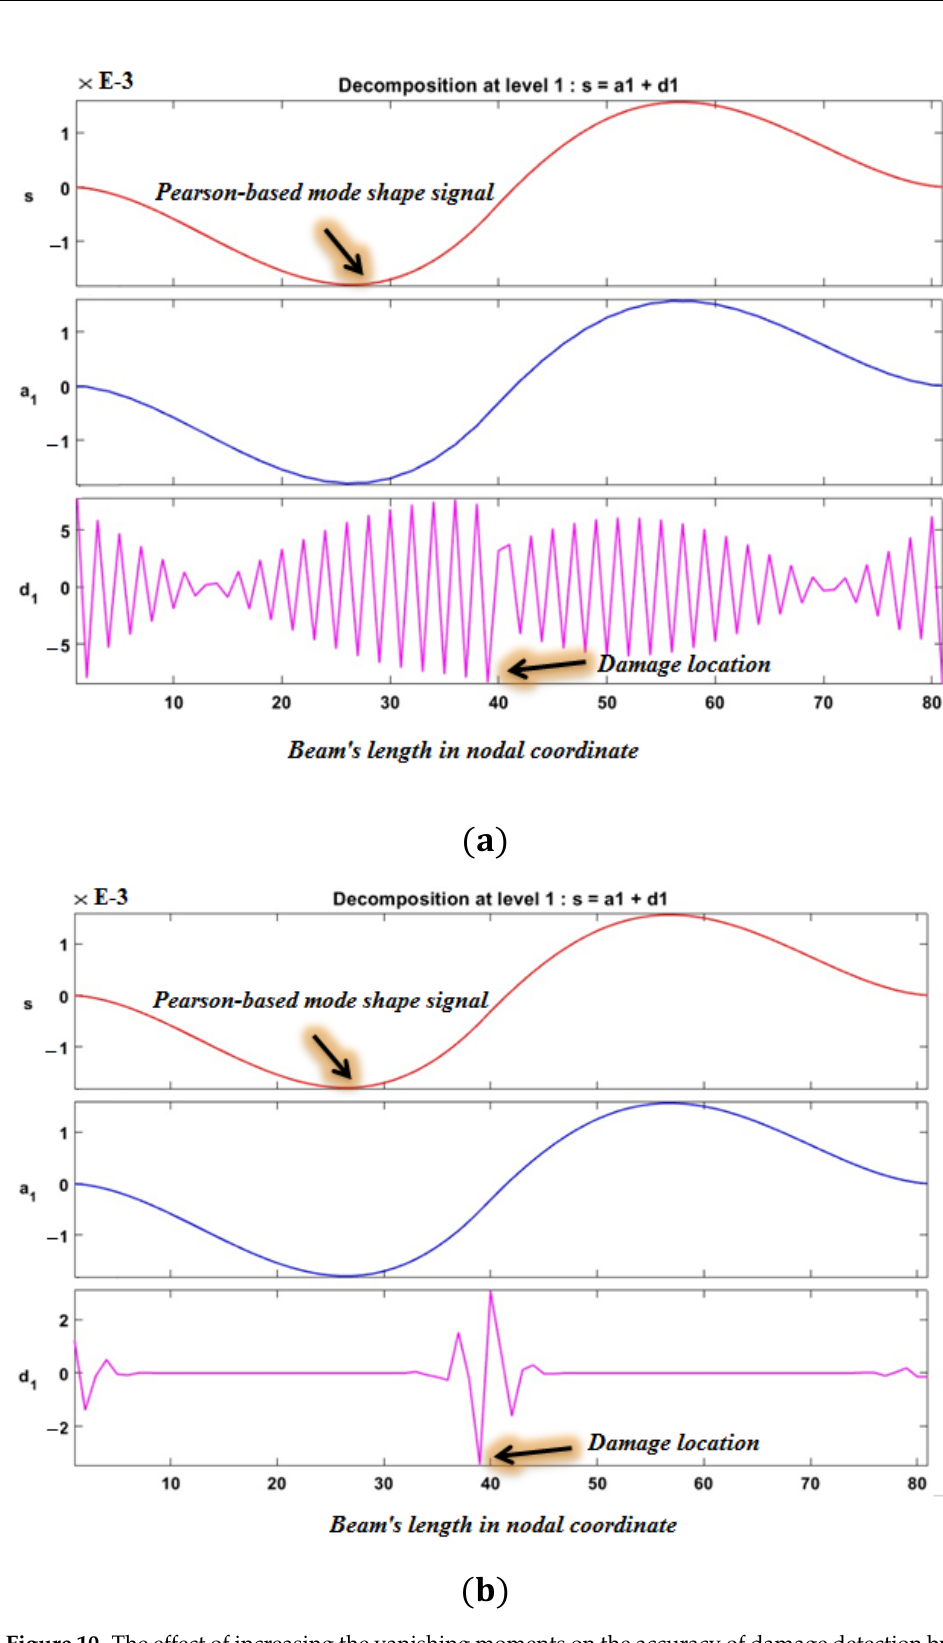
Figure 10. The effect of increasing the vanishing moments on the accuracy of damage detection by 1D-DWT from the quasi-Pearson-based mode shape signal by 70% damage: ( a ) vanishing moments = 2, ( b ) vanishing moments = 5.